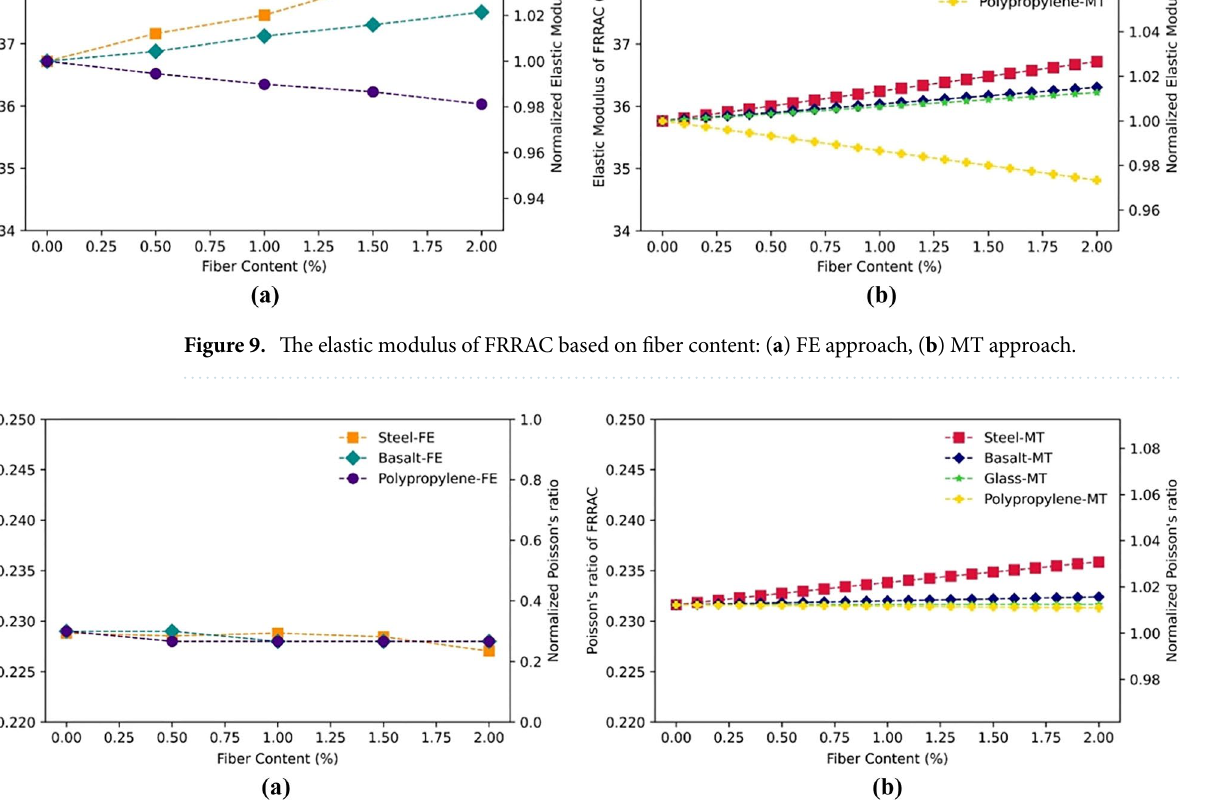
Figure 10. The Poisson’s ratio of FRRAC based on fiber content: ( a ) FE approach, ( b ) MT